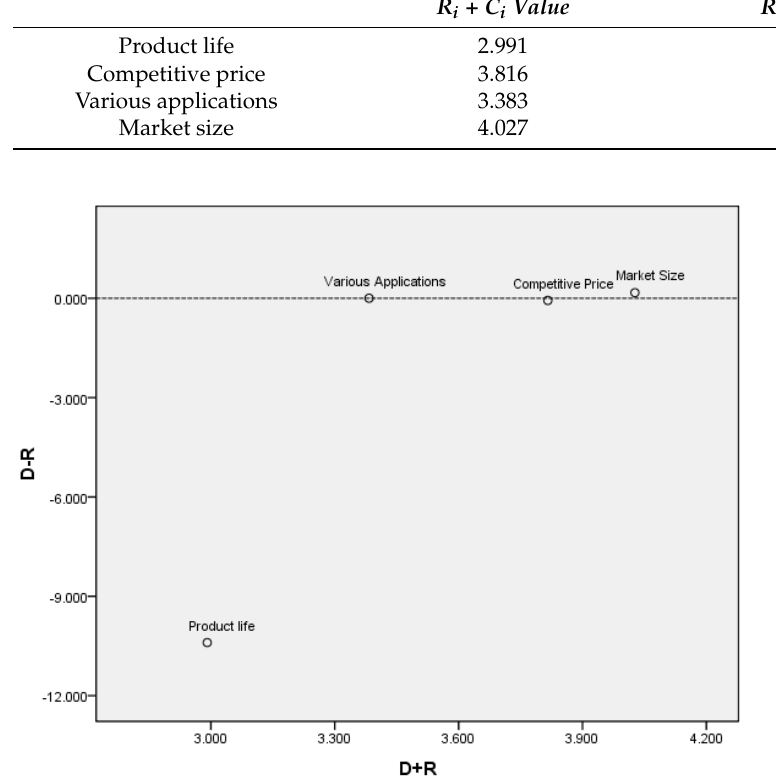
Figure 3. Graph of appearing causal relationship of the market benefit criteria.